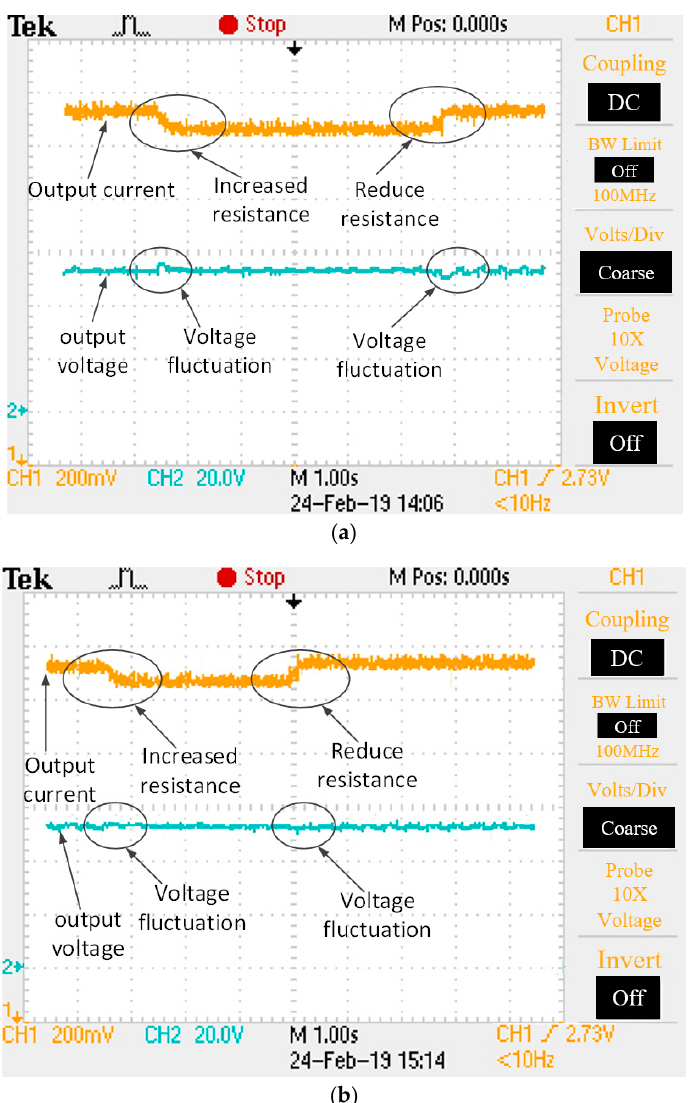
Figure 17. System output response under different control strategies. ( a ) Voltage feedback control system output; and ( b ) feedforward-double feedback control system output.